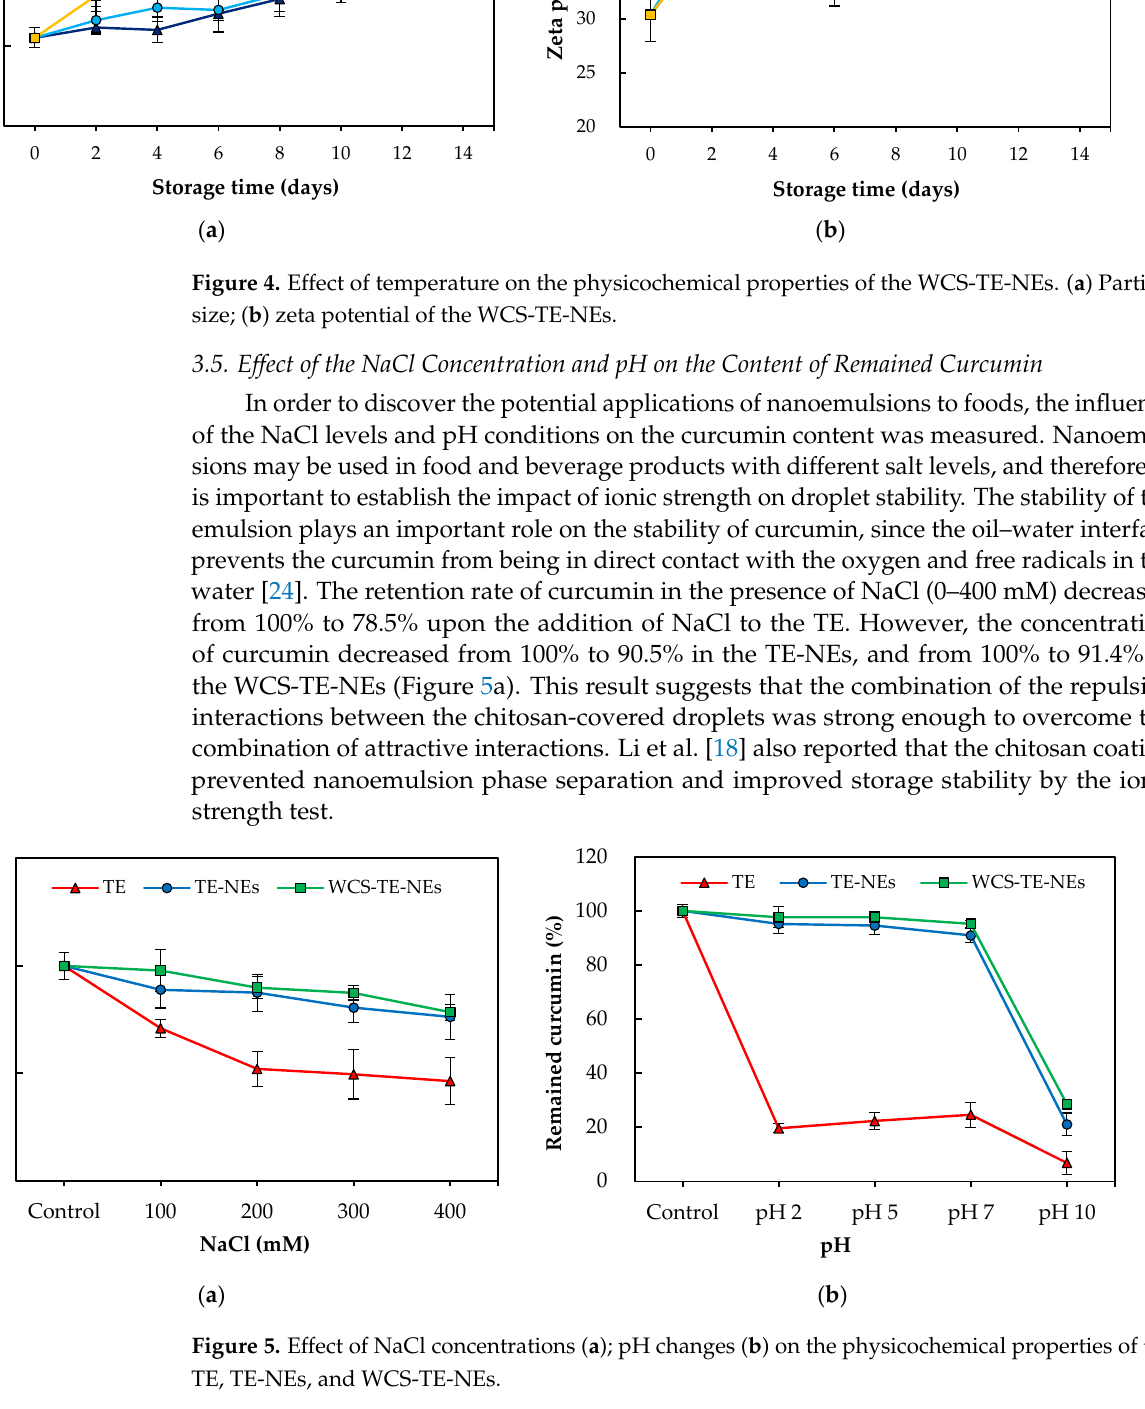
Figure 4. Effect of temperature on the physicochemical properties of the WCS-TE-NEs. ( a ) Particle size; ( b ) zeta potential of the WCS-TE-NEs.